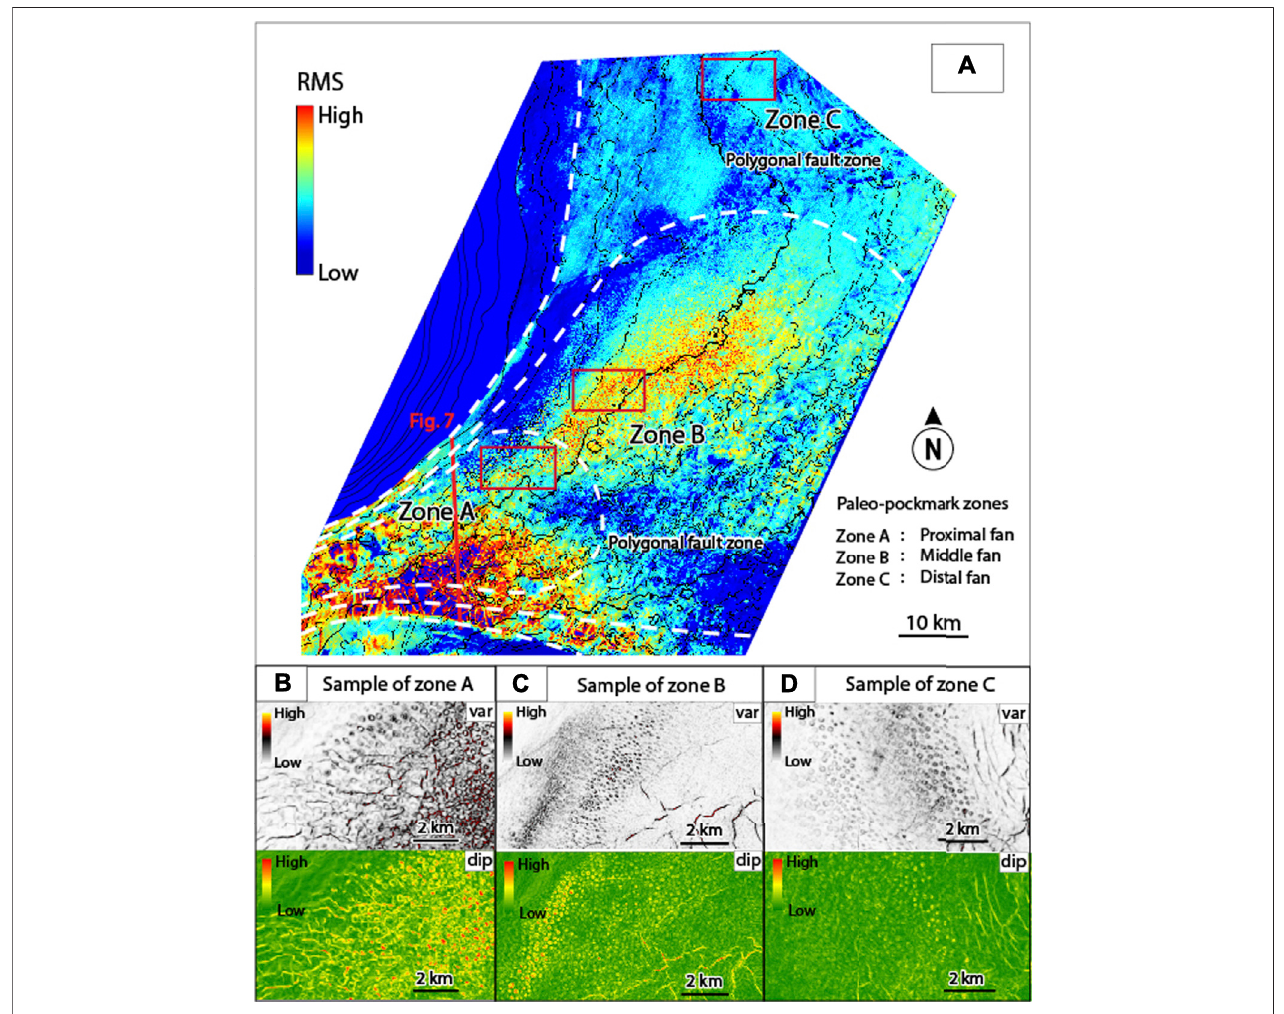
FIGURE 6 | (A) RMS amplitude attribute map extracted from the 0 – 50 ms (TWT) interval below the top surface of the Laing Formation. Paleo-pockmarks are distributed in a fan-shaped body. The variance (var) and consistent dip (dip) images show the samples of the paleo-pockmark from zones A, B, and C. (B – D) Zoom-in images from the selected locations show the geometric measurements which are indicated by red rectangles. White dashed lines are the boundary of the zones.